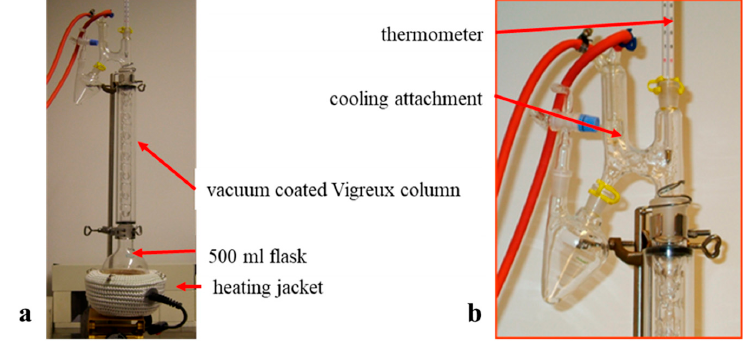
Figure 3. ( a ) Distillation unit; ( b ) special distillation cooling attachment.